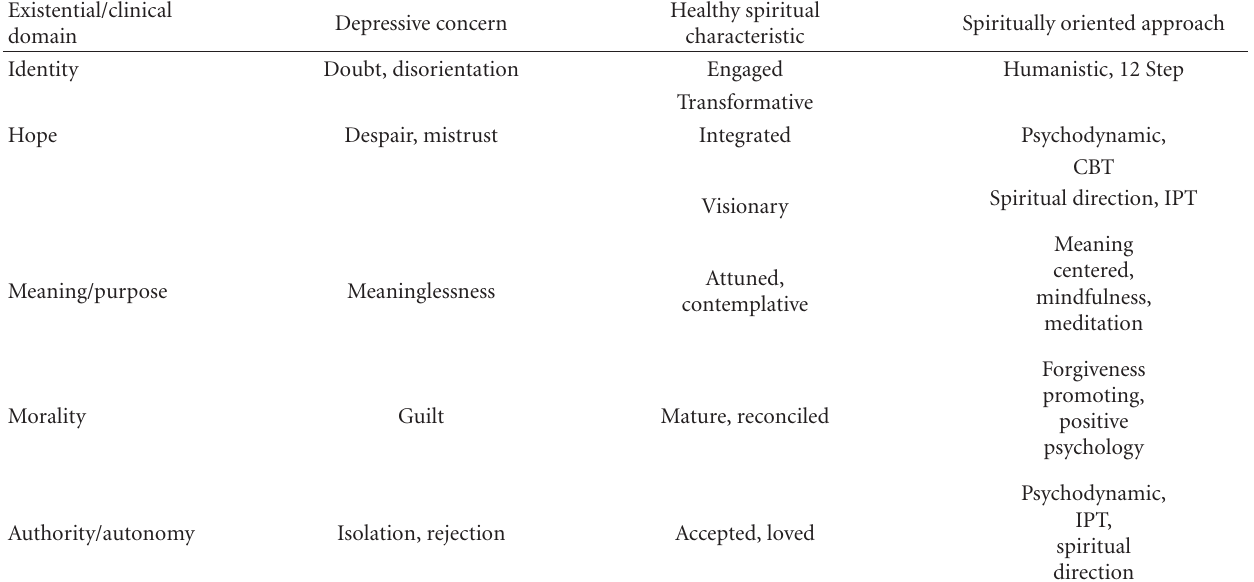
Table 2: The relationship of spiritually oriented interventions to depressive